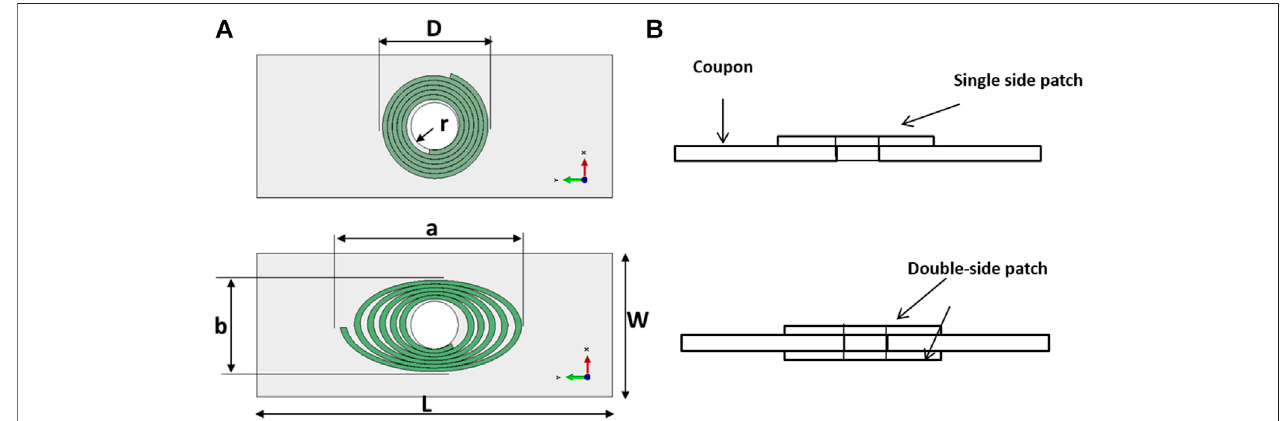
FIGURE 12 | Sketches of the virtual test samples: (A) sketches of the CA- and EA-reinforced samples; (B) sketches of SSR and DSR samples. The dimensions of the sample are L (cid:1) 150 mm, W (cid:1) 60 mm, T (cid:1) 2 mm, r (cid:1) 10 mm, D (cid:1) 47 mm, a (cid:1) 41 mm, and b (cid:1) 80 mm.